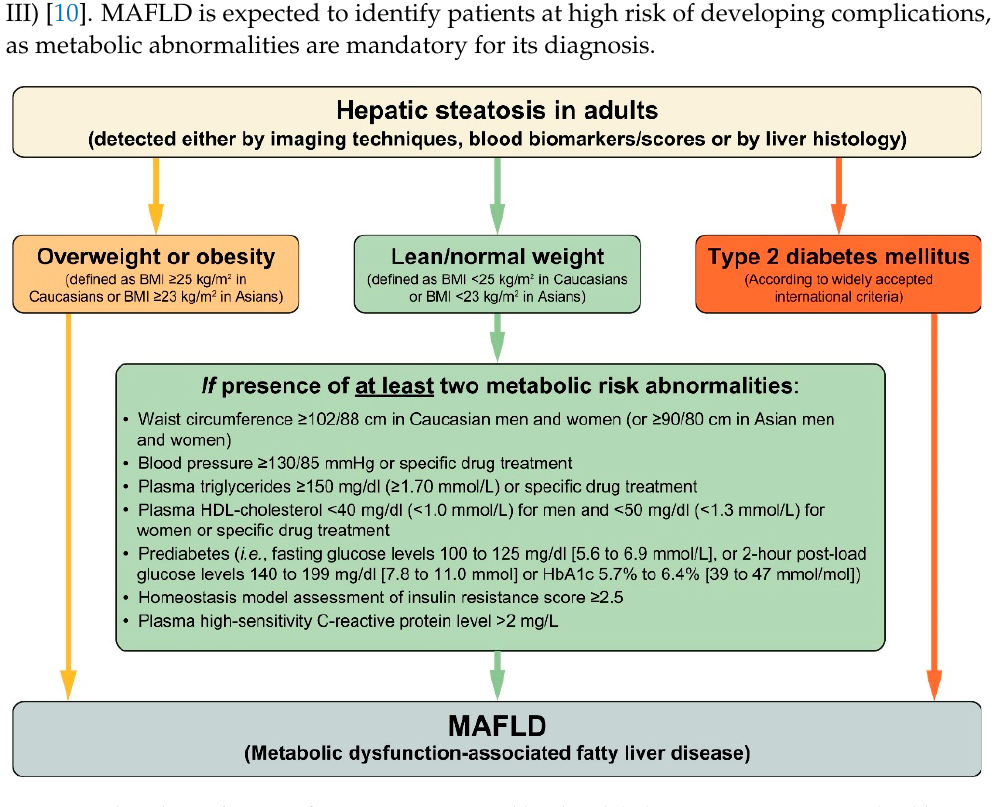
Figure 1. Flowchart of criteria for MAFLD proposed by the global expert consensus panel. Abbreviations: MAFLD, metabolic abnormality-associated fatty liver disease. Adapted with permission from Ref. [7] , 2020, Eslam et al.